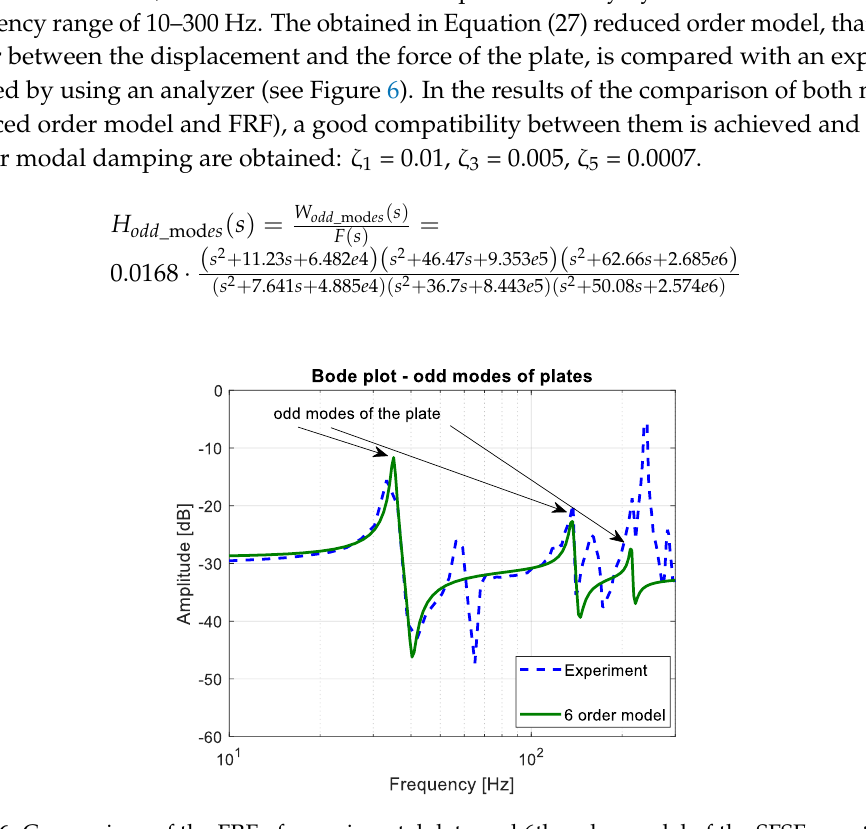
Figure 6. Comparison of the FRF of experimental data and 6th order model of the SFSF smart plate obtained for excitation by the piezo-stripe actuator oriented longitudinally to X axis (PA_1).